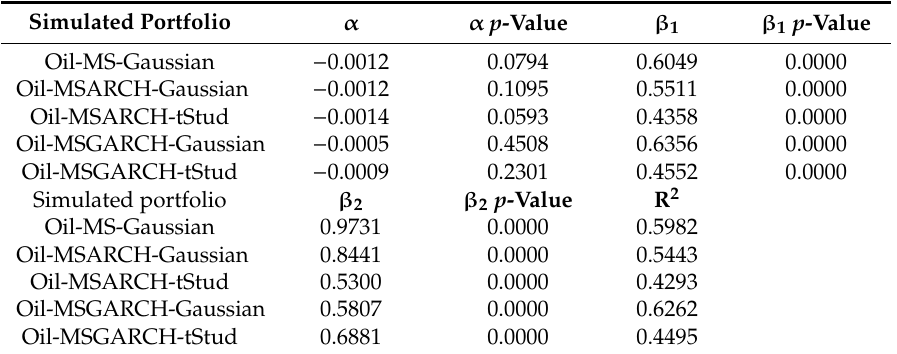
Table 7. Attribution and market timing test of the five simulated portfolios in the OIL market. Simulated Portfolio